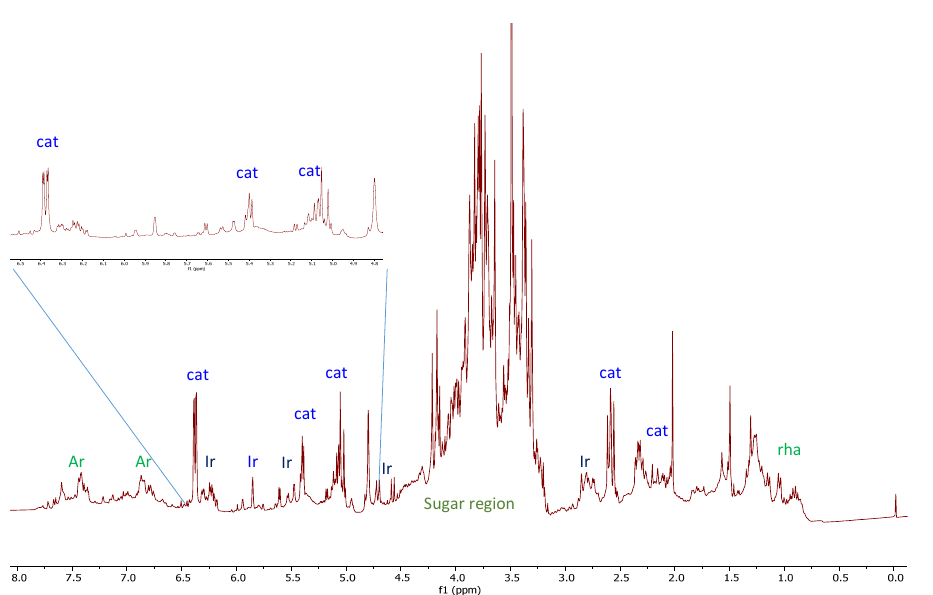
Figure 1. 1 H ‐ NMR spectra of S. trifoliata. Spectra were acquired at 300 MHz, in 1:1 methanol ‐ d4: phosphate buffer. Diagnostic signals of the main metabolites detected in extract are indicated by the following abbreviations: Ar = aromatic compounds, cat = catalpol ( 1 ), Ir = others iridoids, rha = rhamnose.